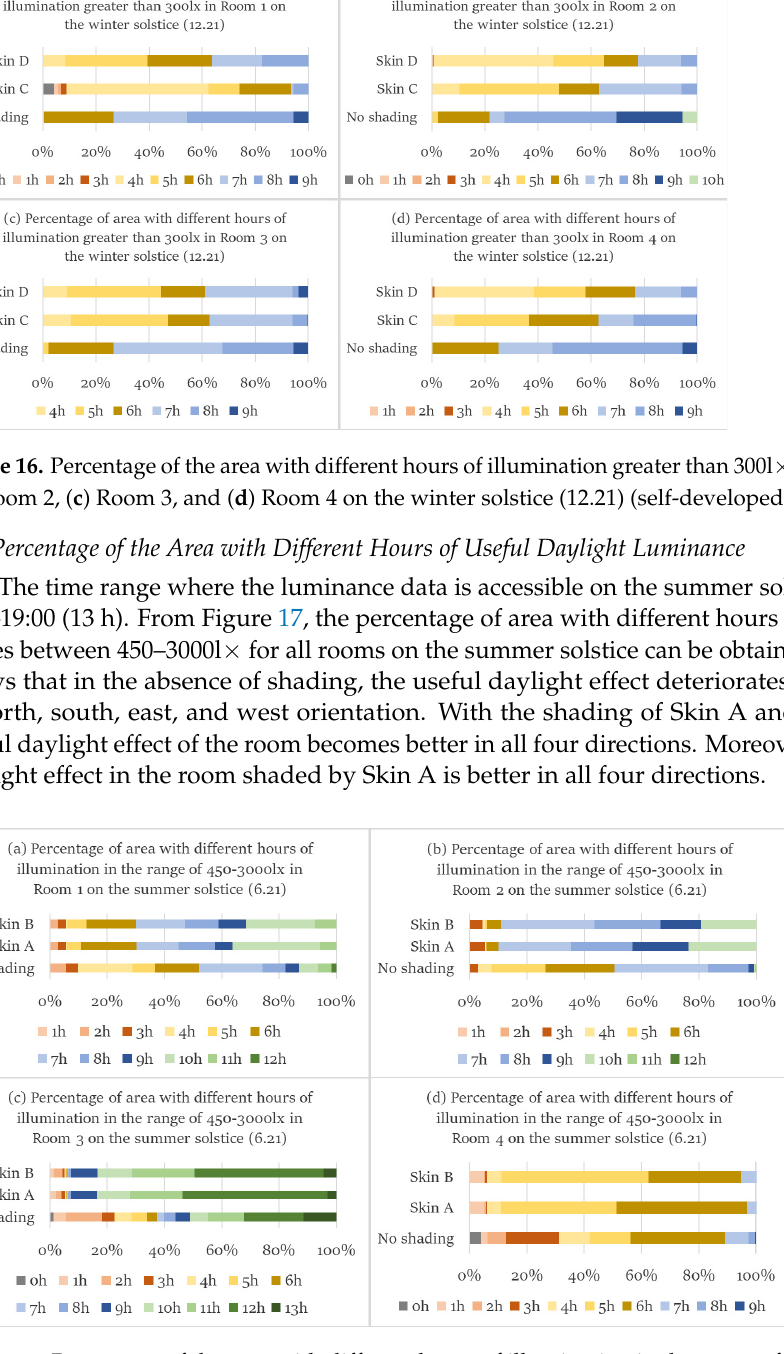
Figure 15. Percentage of area with different hours of illumination greater than 300l× in ( a ) Room 1, ( b ) Room 2, ( c ) Room 3, and ( d ) Room 4 on the summer solstice (6.21) (self-developed). The time range of luminance data accessible on the winter solstice (12.21) is 8:00– 17:00 (10 h). Figure 16 presents the percentage of area with different hours of luminance exceeding 300l× in all rooms on the winter solstice, demonstrating that, in the absence of number of hours with luminance of more than 300l × at the test points in the east-facing room shading, the number of hours with luminance of more than 300l× at the test points in the was longer than in the south-, north-, and west-facing rooms. When using the shading of Skin east-facing room was longer than in the south-, north-, and west-facing rooms. When C and D, the luminance in all four directions of the room was reduced, by around 1–2 h, as using the shading of Skin C and D, the luminance in all four directions of the room was most of the test points have more than 4 h of luminance exceeding 300l × . For the south and reduced, by around 1–2 h, as most of the test points have more than 4 h of luminance exceeding 300l×. For the south and north orientation, the rooms are better lit naturally north orientation, the rooms are better lit naturally under the Skin C shading, while in the under the Skin C shading, while in the east- and west-facing directions, the rooms are east- and west-facing directions, the rooms are better lit by natural light under Skin C. better lit by natural light under Skin C.